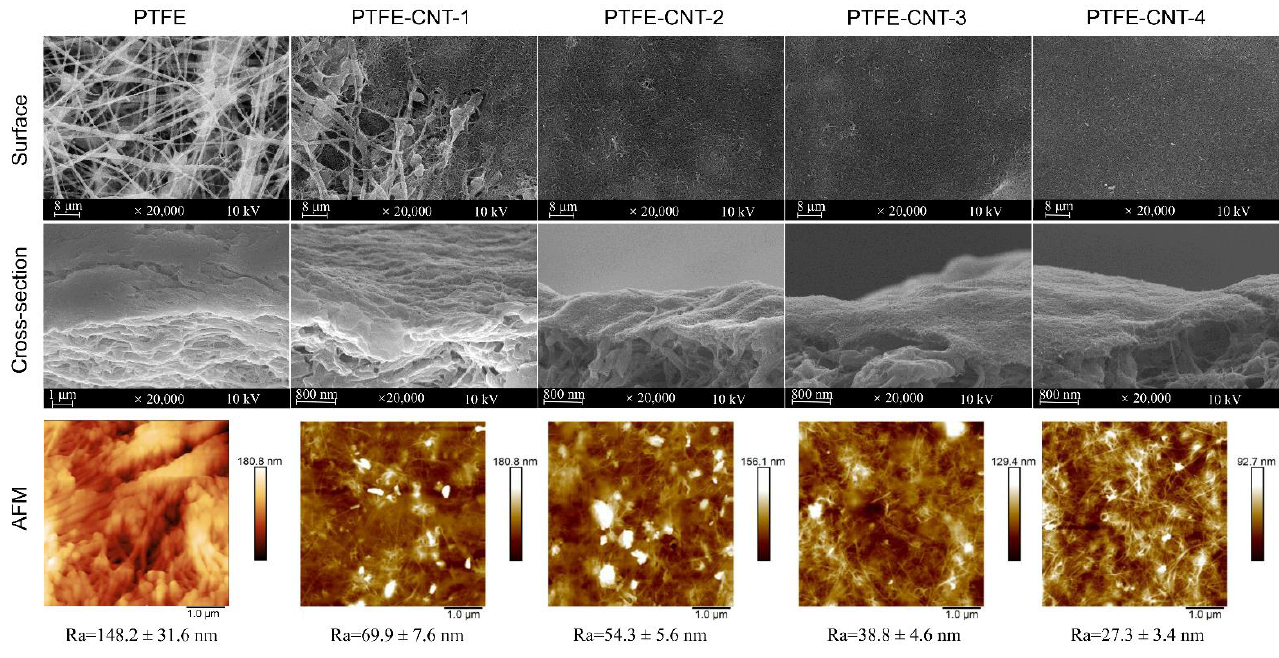
Figure 3. Surface and cross-sectional SEM images of the PTFE-CNT membranes as well as their corresponding surface AFM images. Table 2. Structure and properties of the Pristine PTFE and the PTFE-CNT Membrane.